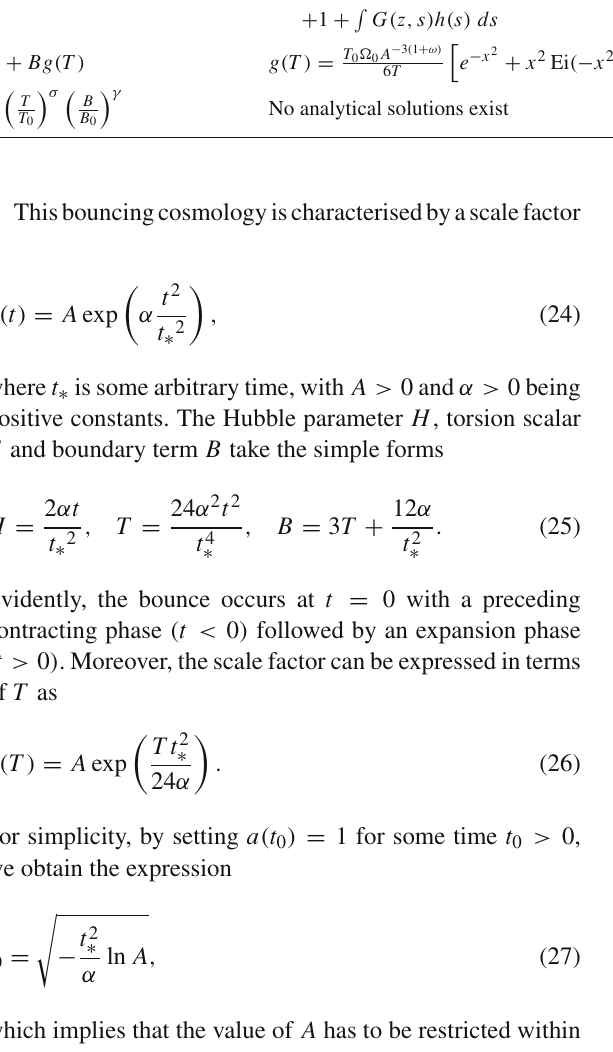
plify the form of the solutions. Here, C 1 , 2 , 3 are integration constants, erf ( x ) is the error function and L b a ( x ) ≡ L [ a , b , x ] is Laguerre’s function. The Green’s function G ( z , s ) and h ( s ) are as defined , 2 y